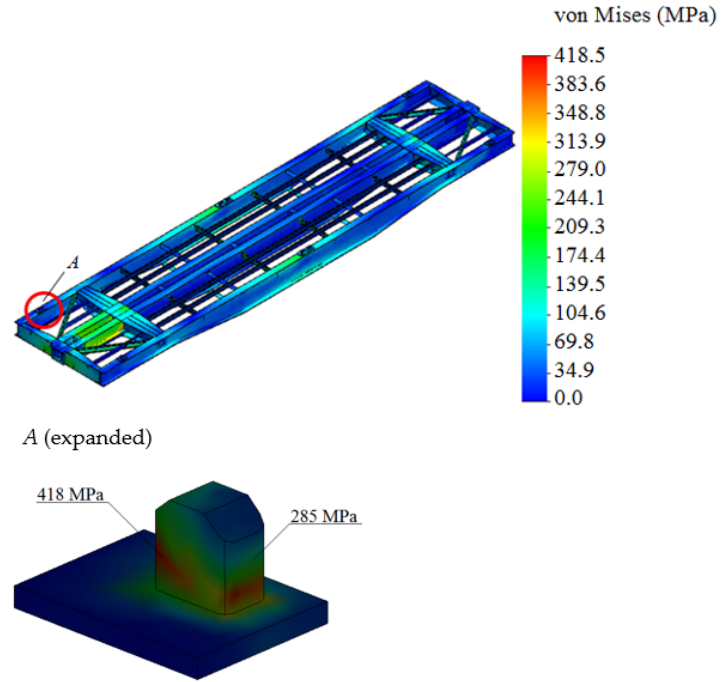
Figure 4. Stress state of the flatcar